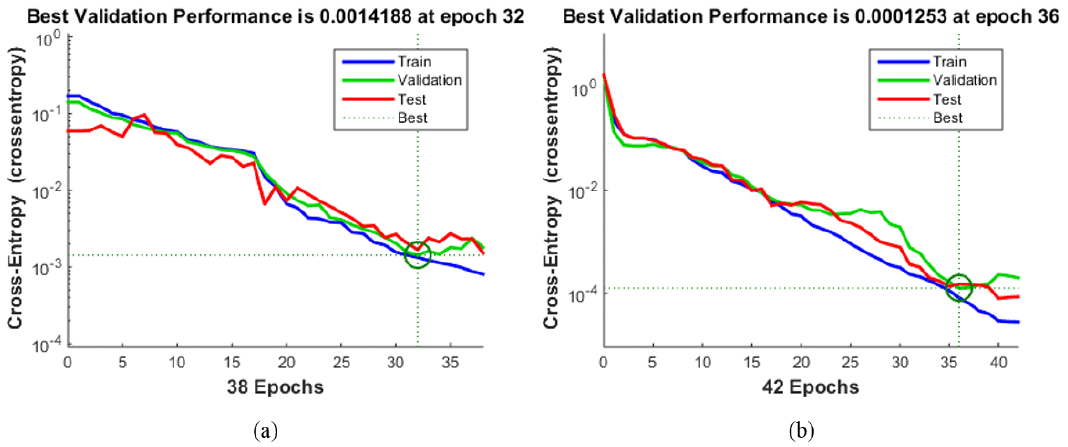
Figure 10. Cross entropy graph of NN according to epoch for the performance analysis: ( a ) NN with the physical sensor was only trained for 38 epochs, and ( b ) NN with EMG fusion was trained for 42 epochs.